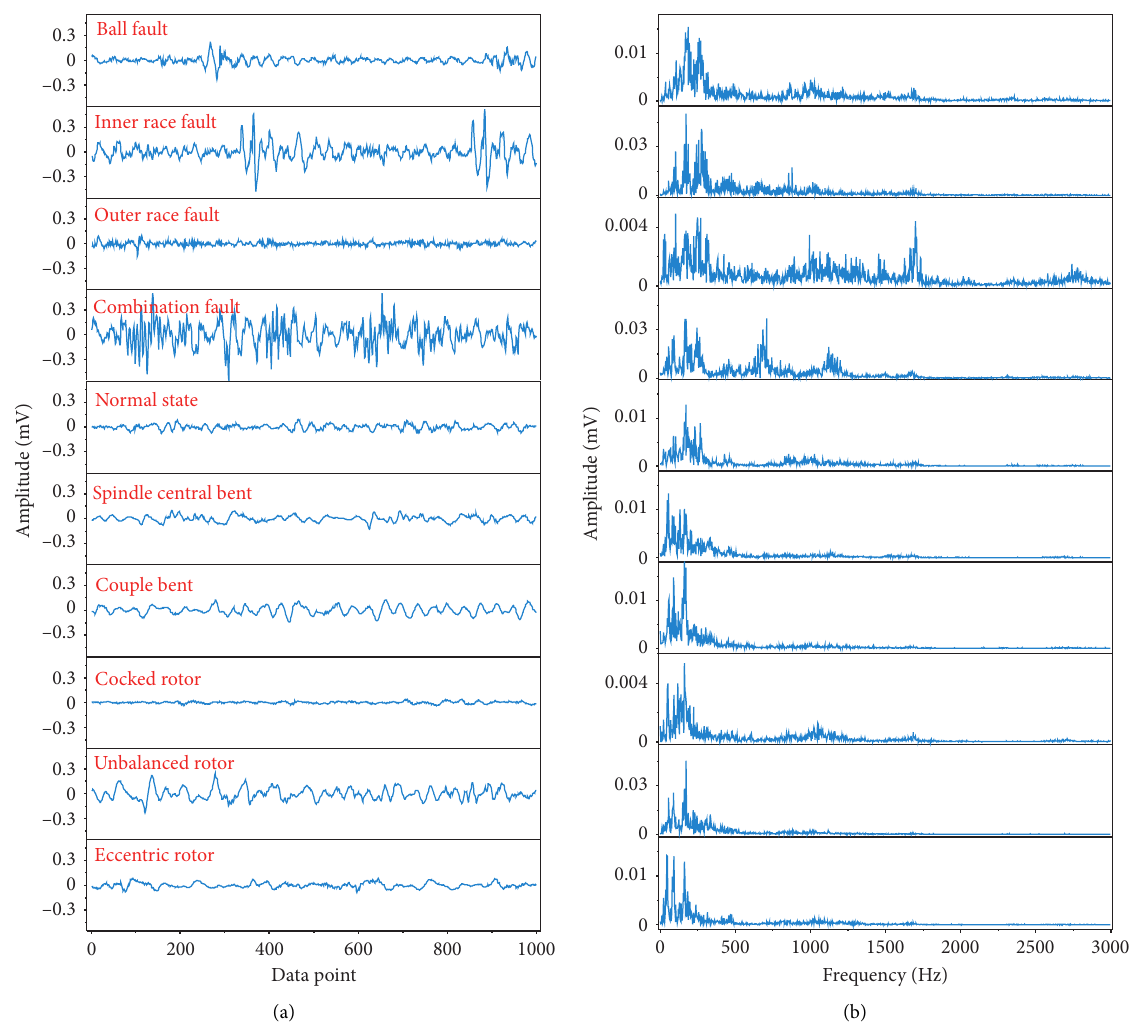
Figure 5: Time- and frequency-domain waveforms of ten fault types. (a) Time domain. (b) Frequency